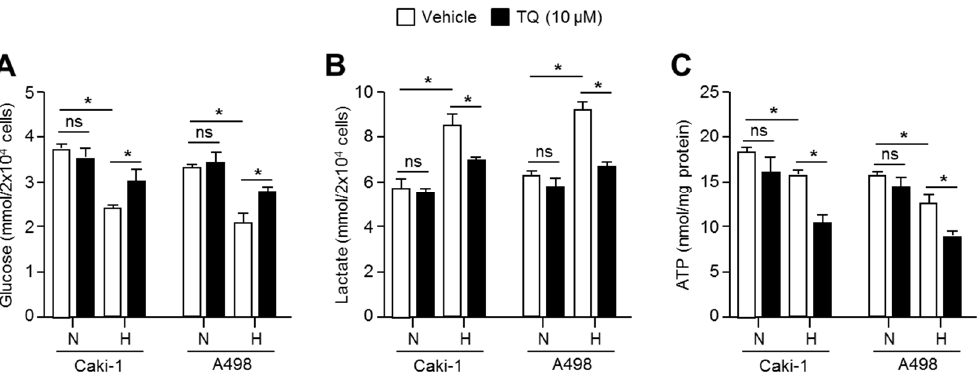
Figure 6. TQ alters glucose-dependent metabolism under hypoxia in renal cancer cells. ( A ) Glucose consumption was measured in Caki-1 and A498 renal cancer cells. Cells were incubated with or without 10 µ M of TQ for 24 h under normoxia or hypoxia. ( B ) Lactate production was evaluated. Caki-1 and A498 cells were incubated with or without 10 µ M of TQ for 24 h under normoxia or hypoxia. ( C ) Intracellular ATP levels were measured in Caki-1 and A98 cells in the absence or presence of TQ under normoxia or hypoxia. The values represent the mean ± SD of three independent experiments performed in duplicate; * p < 0.05.